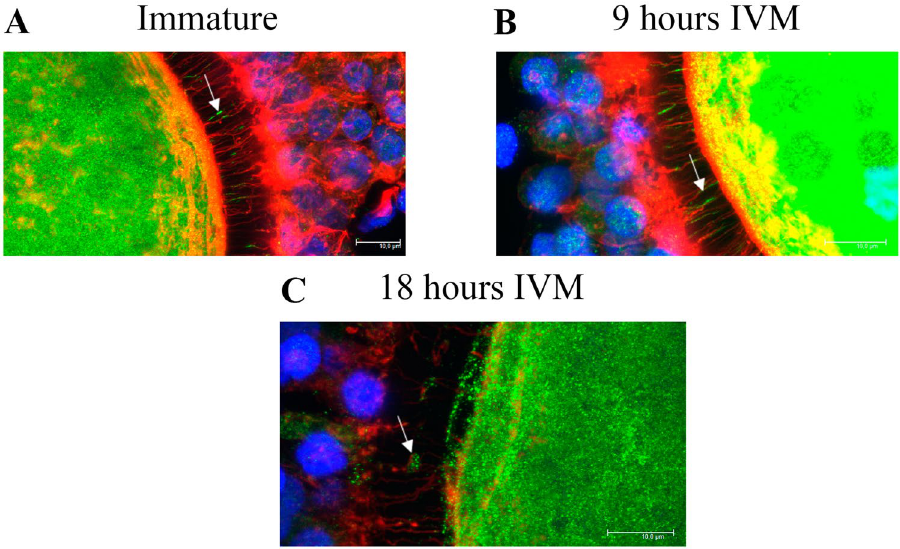
Figure 6. Confocal microscopic analysis of cumulus-oocytes complexes (COCs) at different stages of oocyte maturation (merge of z-stack images) in 63 x objective with digital zoom. ( A ) Photomicrograph showing the localization of fatty acid binding protein 3 (FABP3) and tranzonal projections (TZPs) in immature COCs. ( B ) Photomicrograph showing the localization of FABP3 and TZPs in COCs after 9 h of maturation. ( C ) Photomicrograph showing the localization of FABP3 and TZPs in COCs after 18 h of maturation. Arrows indicate FABP3 immunolocalized in TZPs. FABP3 is immunostained using 488 Alexa Fluor (green); TZPs (actin) are stained with Alexa Fluor 647 phalloidin (red); nuclei are stained with DAPI (blue).